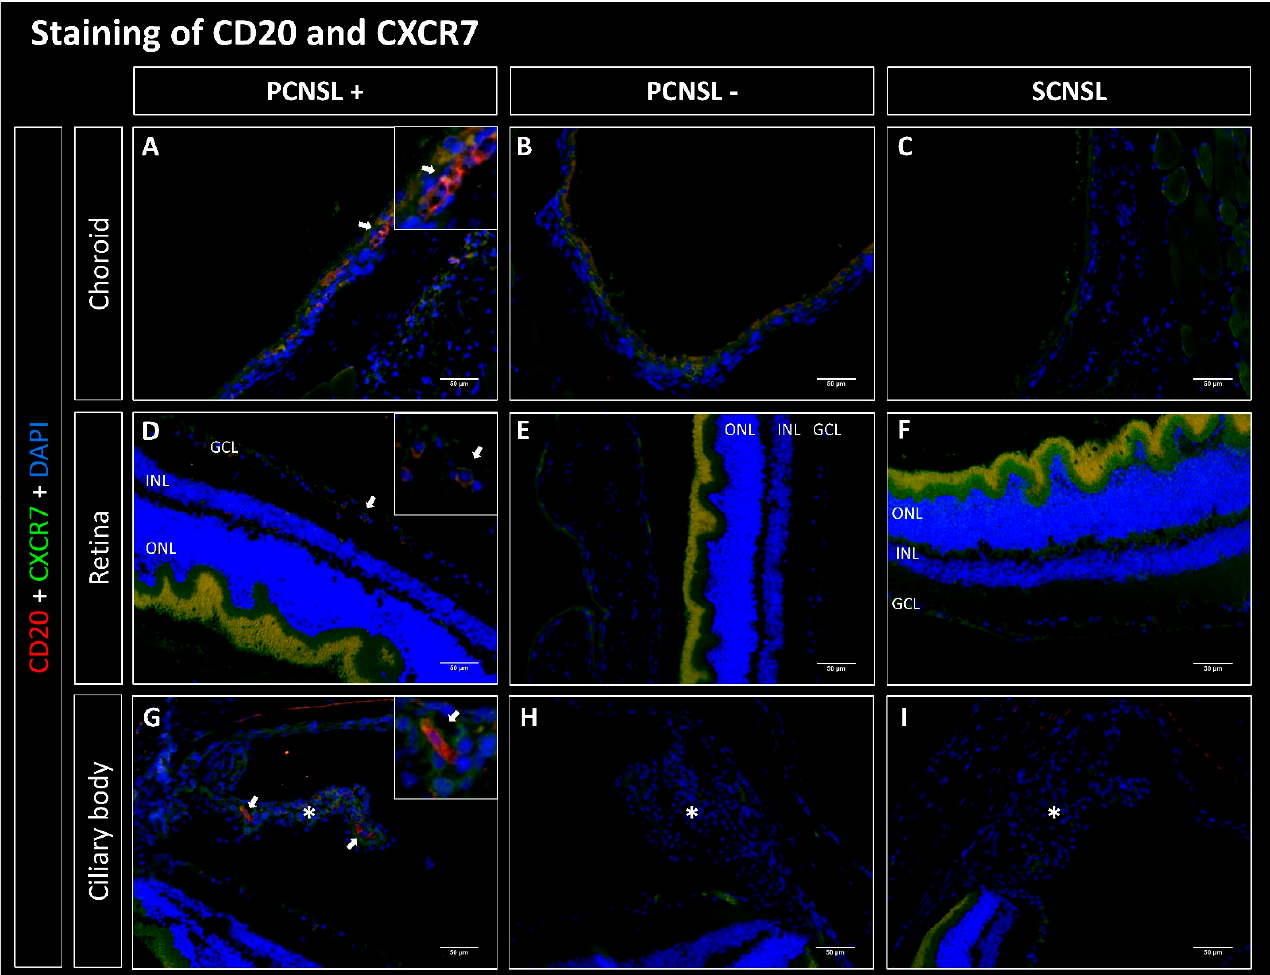
Figure 3. Fluorescence microscopy of CD20 (red) and CXCR7 (green) double staining of the eyes in the PDX PCNSL vs. PDX SCNSL group. ( A – C ) show recordings of the choroid, ( D – F ) of the retina and ( G – I ) of the ciliary body (marked with *). ( A , D , G ) show the choroids, retinas, and ciliary bodies infiltrated with CD20-positive primary CNS lymphoma cells (PCNSL+) (arrows). Hardly any CXCR7-positive staining was found. No CD20+ cells were found in the PCNSL negative (PCNSL-) group ( B , E , H ) and in the SCNSL group ( C , E , I ). In the PCNSL- and SCNSL groups, CXCR7 stained faintly in the choroids ( B , C ), weakly to moderately in the retinas ( E , F ) and moderately in the ciliary body ( H , I ). ONL = outer nuclear layer, INL = inner nuclear layer, GCL = ganglion cell layer; scale bar 50 µm.